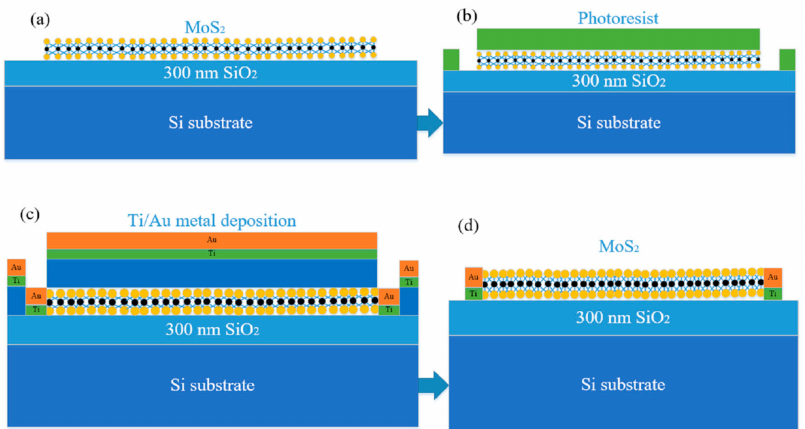
Figure 3. The main preparation process schematic diagram of the monolayer MoS 2 -based field e ff ect transistor (FET; ( a )) the growth process of the high-quality triangular monolayer MoS 2 ; ( b ) the photolithography and the Ar plasma etching process; ( c ) the electron beam evaporation process; and ( d ) the cleaning process of the